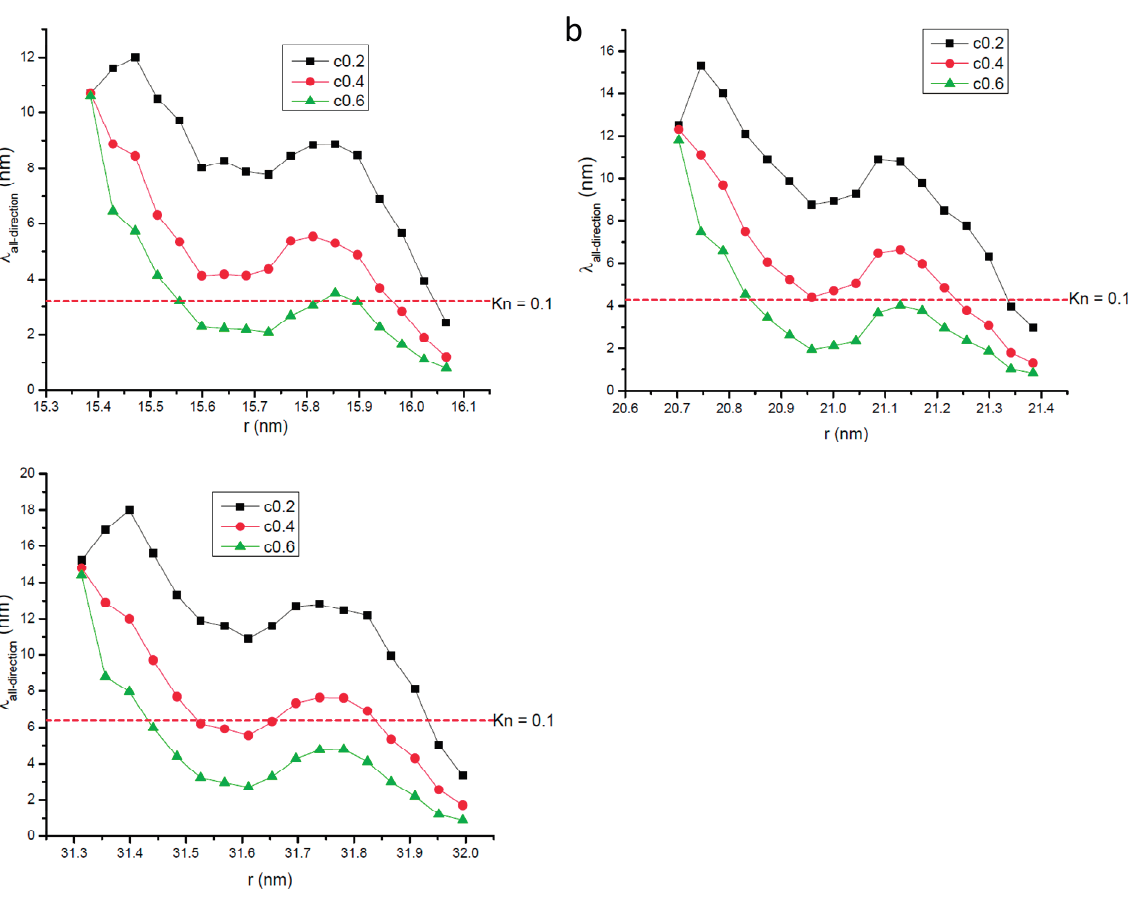
Figure 2. Profile of gas molecular mean free path in the zone 0.7 nm apart from the wall surface of the nanopore; the dotted line means the dividing line of slip regime. ( a ) R = 16.06 nm; ( b ) R = 21.4 nm; and ( c ) R = 32.0